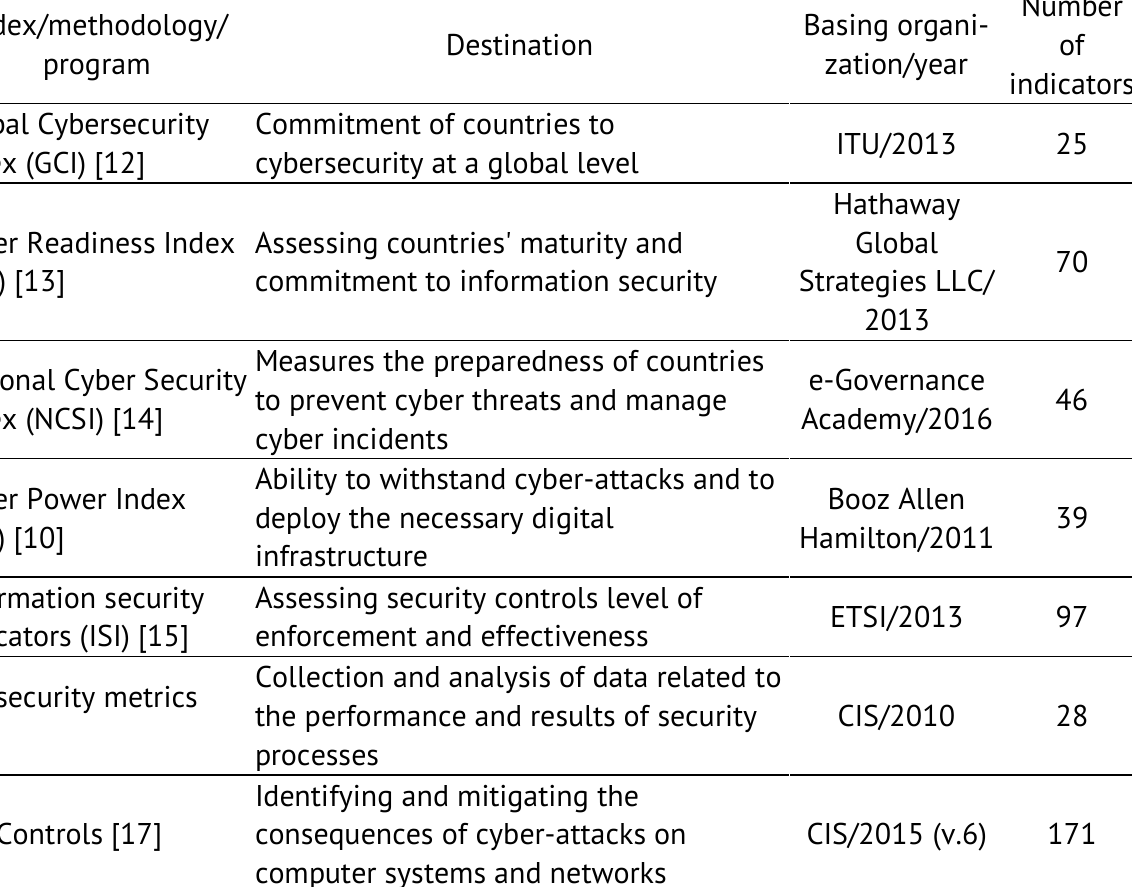
Destination and number of indicators used in some programs and